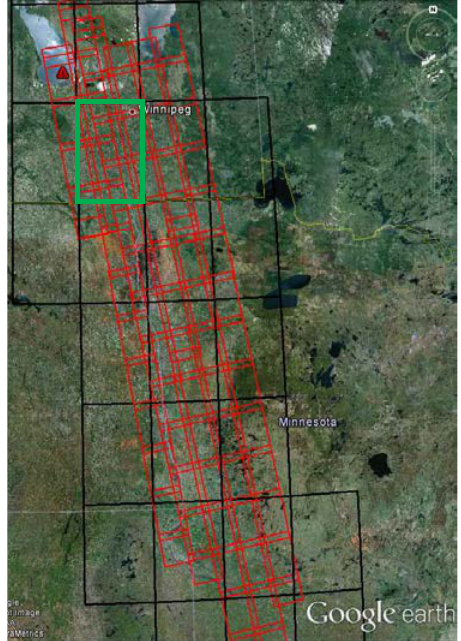
Figure 1: Overview test site Manitoba, RawDEMs marked red,